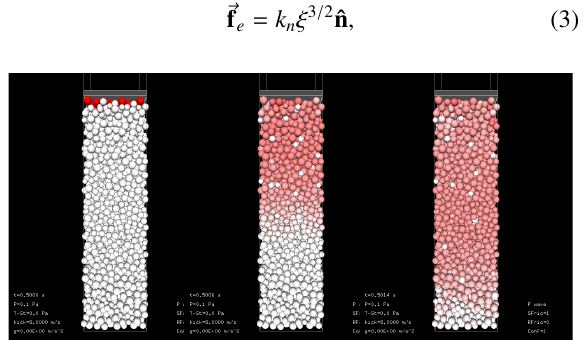
Figure 1. Simulation setup of a randomly packed aggregate; the redder the particle, the greater its vertical speed component ( P = 0.1